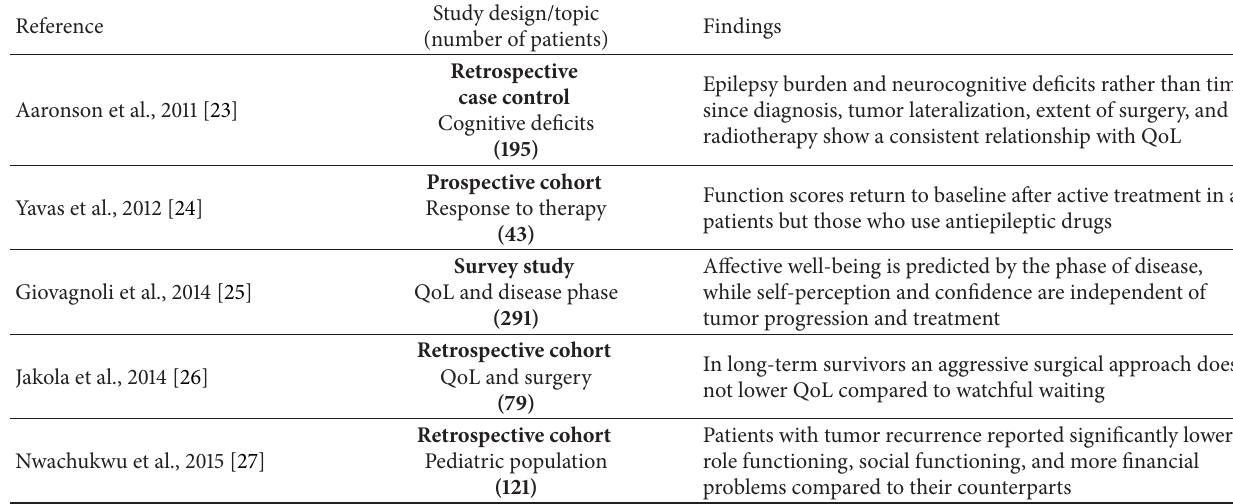
Table 2: QoL studies on